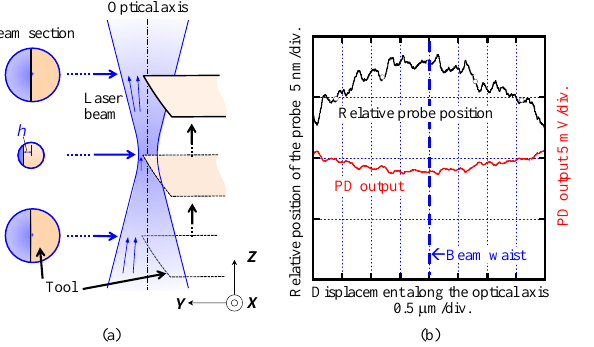
Figure 3. A schematic of the alignment of the tool’s edge with respect to the optical probe. (a) Schematic of the tool positioning. (b) Relation curves for PD output, displacement along the Z -direction and the relative probe position converted from PD output.